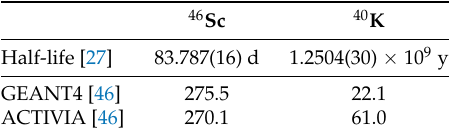
Table 9. Rates of production of long-lived radioisotopes induced in titanium at sea level. Measurements from different calculations are presented (see text). All numbers are expressed in